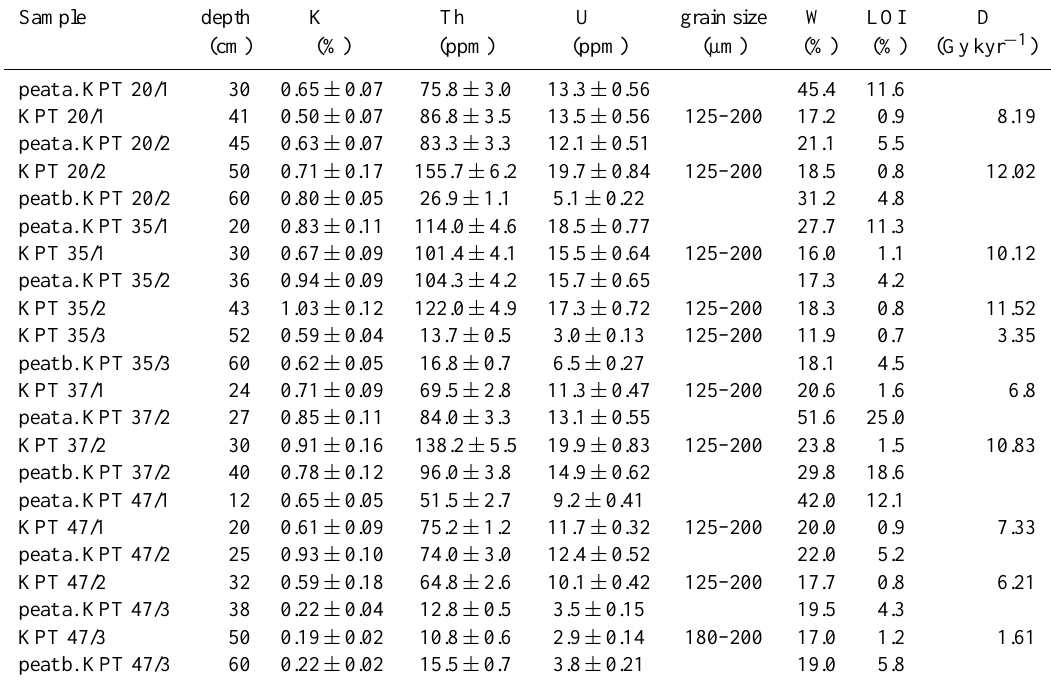
Table 1. Dosimetry data of all samples. Depth = depth below surface, K = potassium content, Th = thorium content, U = uranium content, W = water content, LOI = loss on ignition, D = dose